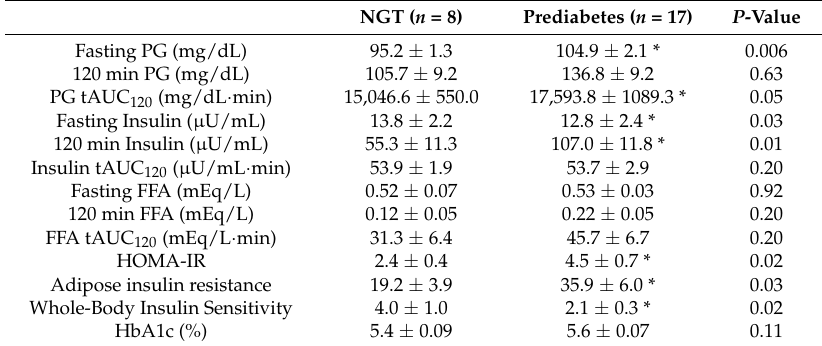
Table 2. Glucose regulation in adults with normal glucose tolerance (NGT) and prediabetes. NGT ( n = 8)